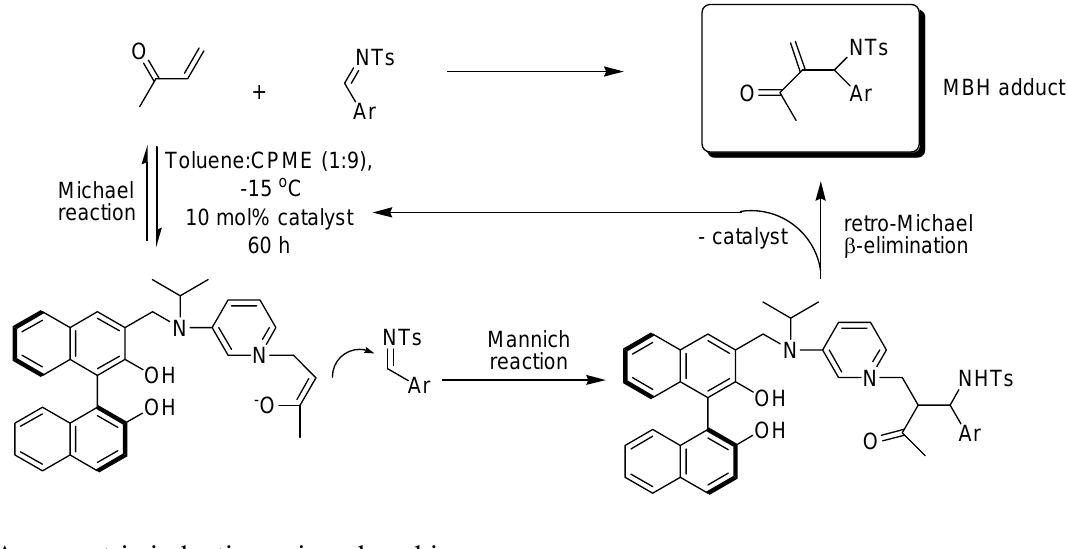
Scheme 13. Mechanism of MBH reaction methyl vinyl ketone and phenyl- N -tosylimine catalyzed by ( S )-3-( N -Isopropyl- N -3-pyridinylaminomethyl)BINOL ( 27 ).